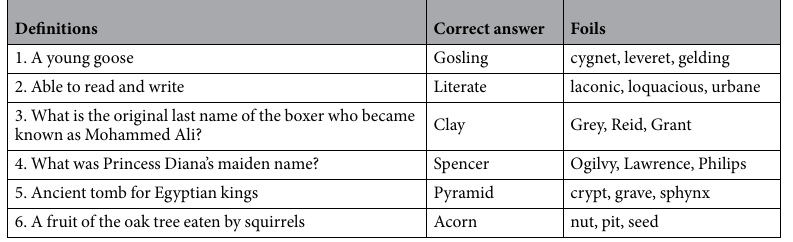
Table 3. Examples of definitions, target words and foils for multiple-choice questions if participants indicated to have experienced a